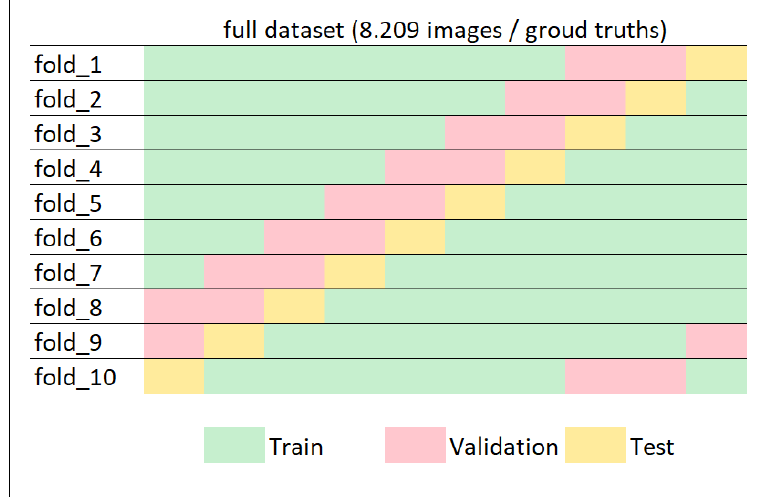
Figure 9. Example demonstrating the distribution of dataset on kfolds .